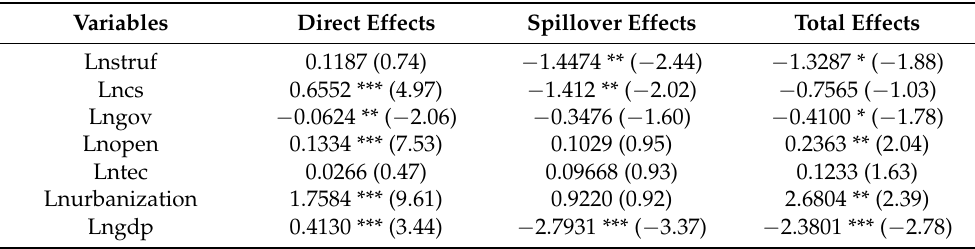
Table 5. Direct effect, spillover effect, and total effect of influencing factors on urban ecological welfare performance.